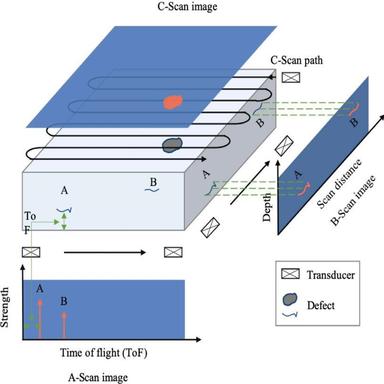
A-scan, B-scan, and C-scan inspection using a pulse-echo UT configuration.